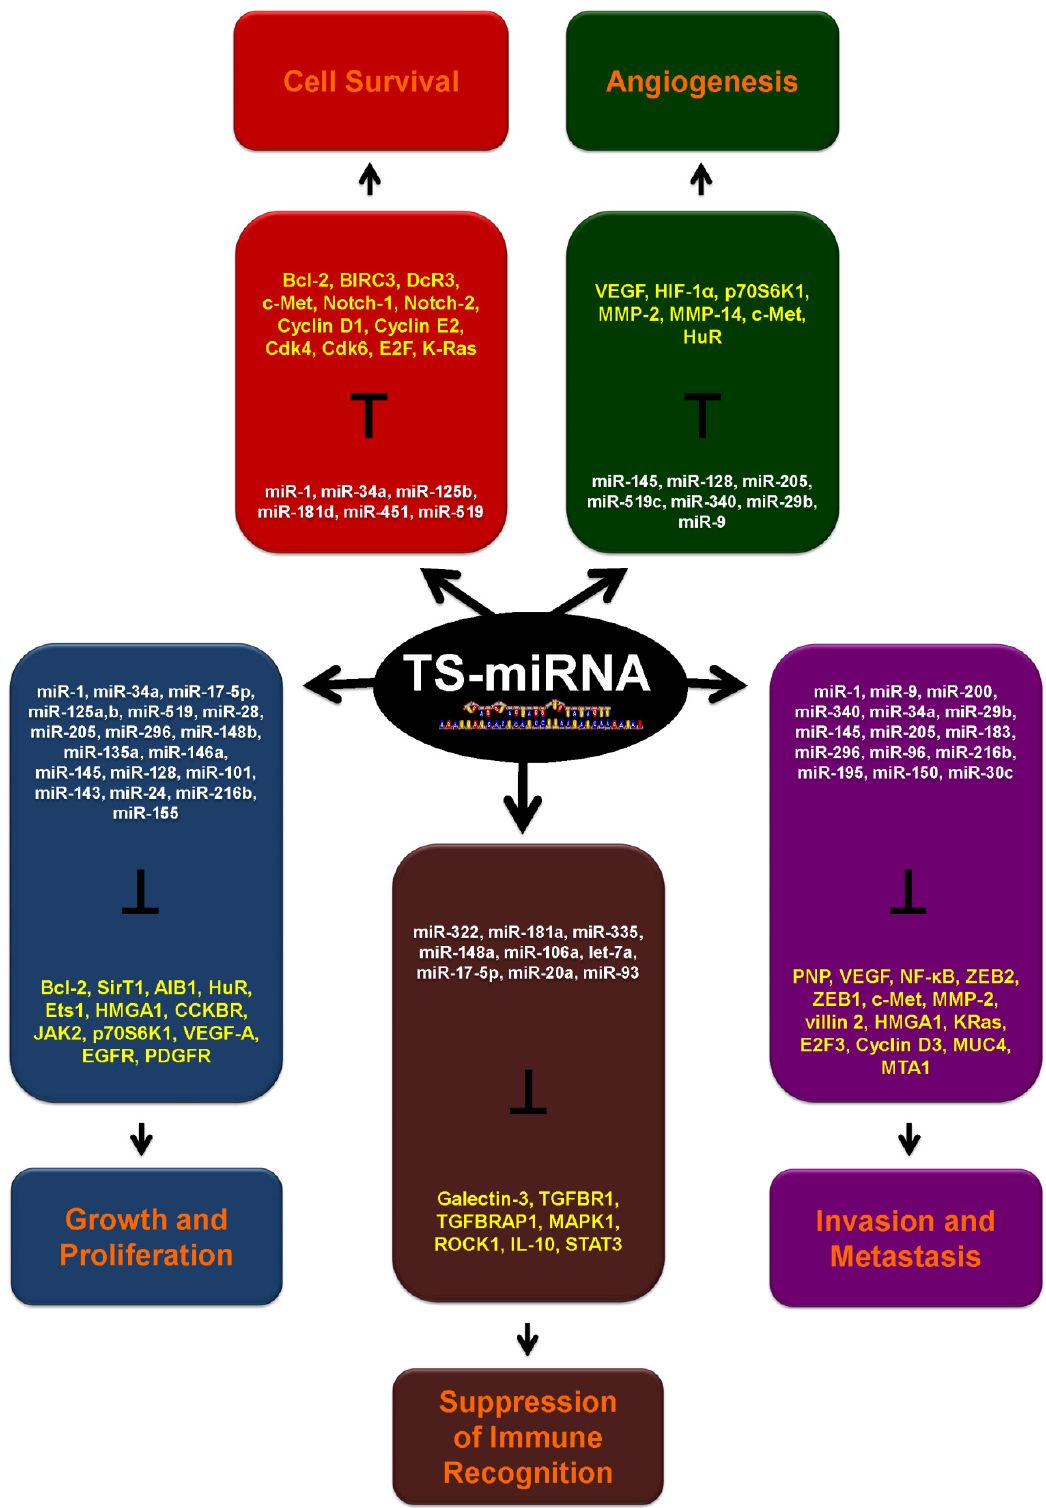
Figure 1. TS-miRNAs and their target mRNAs encoding proteins that enable cancer traits. Boxes depict five major cancer traits: Growth and Proliferation (blue), Cell Survival (red), Angiogenesis (green), Suppression of Immune Recognition (brown) and Invasion and Metastasis (purple). For each cancer trait, TS-miRNAs are indicated in white, the pro-oncogenic proteins encoded by mRNAs that are targets of TS-miRNAs are indicated in yellow and the cancer traits in